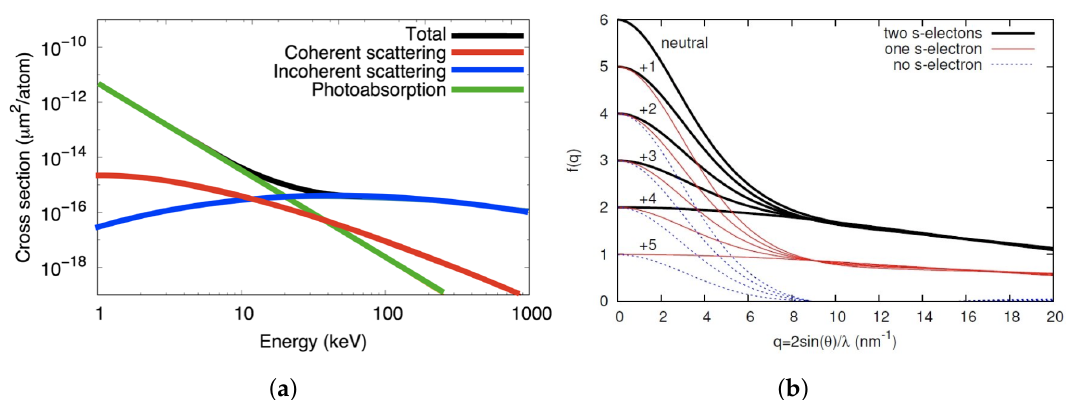
Figure 4. ( a ) Cross sections vs. energy. Atomic cross sections of neutral carbon for photoabsorption, coherent scattering, and incoherent (Compton) scattering. At 10 keV photoabsorption is the dominating interaction. ( b ) Ionic scattering factors. The ionic scattering factors for carbon in different ionization states. Reproduced with permission from Caleman et al. [11]. The term “s-electrons” in the legend refers to the number of electrons occupying the 1 s shell of the